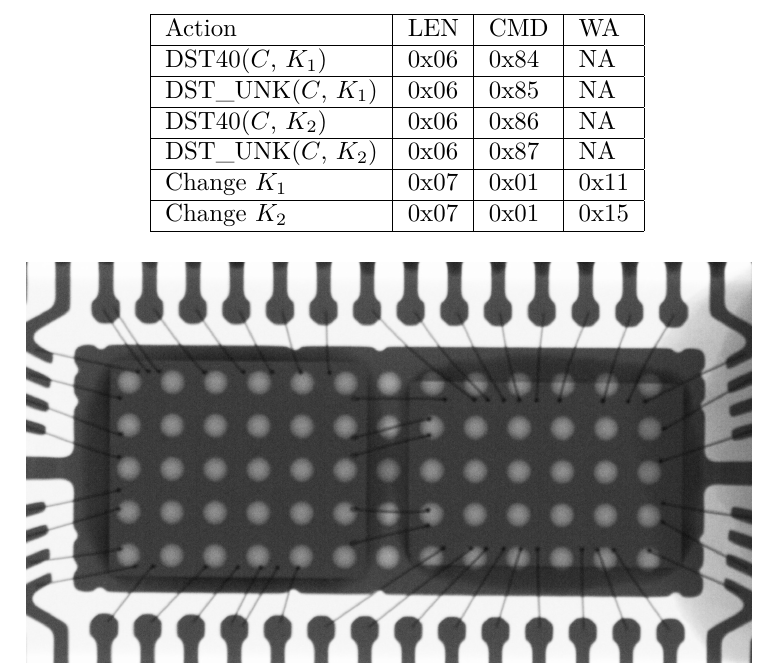
Figure 2: X-ray image of the Texas Instruments TMS37F128. From this image one can identify two dies interconnected by five bond wires. Better viewed